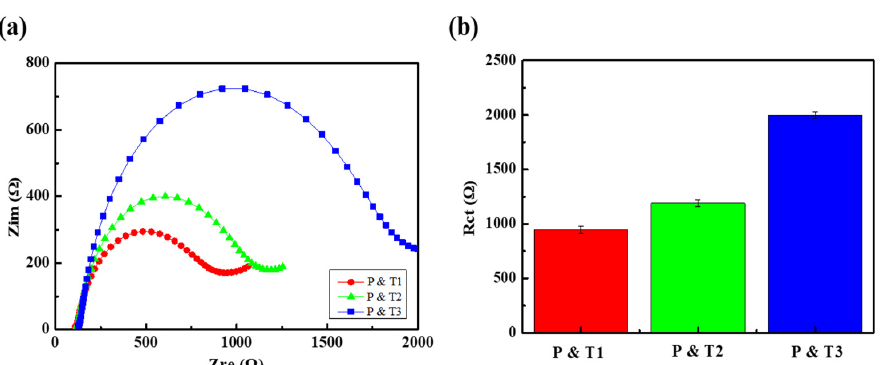
Figure 6. Schematic diagram of DNA detection mechanism.